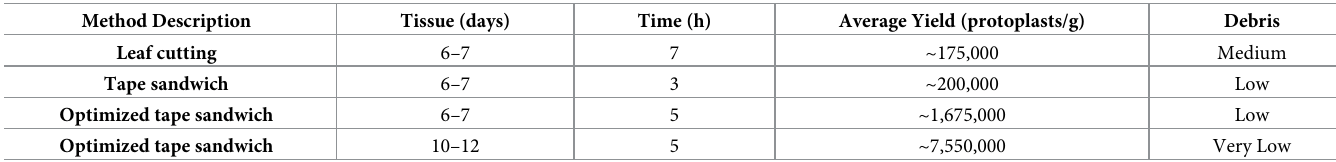
Table 1. Comparison of protoplast isolation